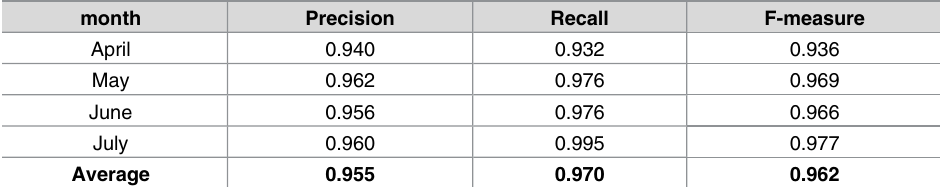
Table 5. The detailed datum of the Experiment C.